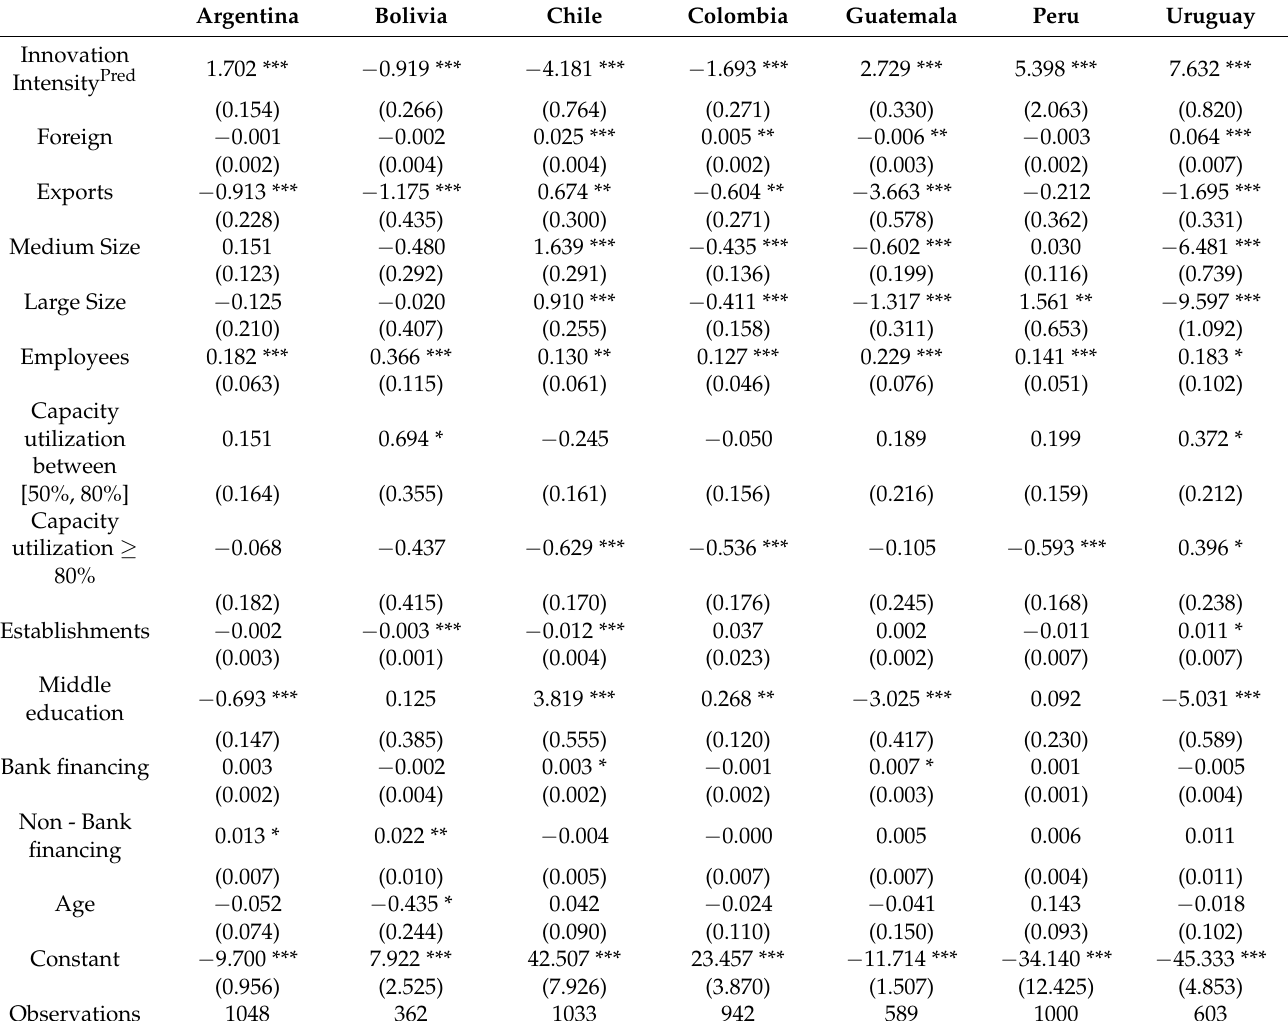
Table 9. Probability of the introduction of product innovations stage 3 CDM